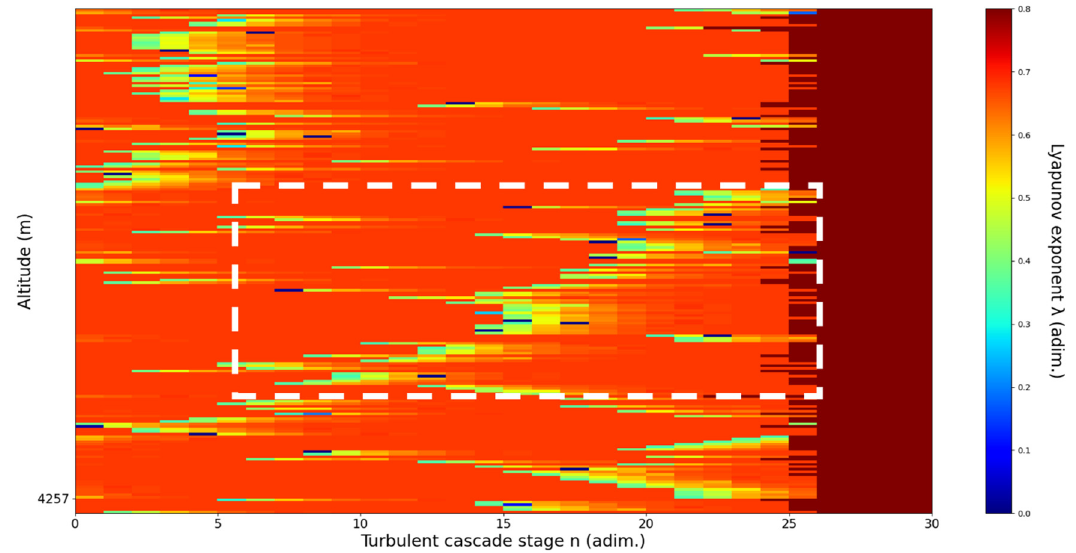
Figure 19. Lyapunov exponent per turbulent cascade stage colormap altitude plot, Bucharest, Romania, 13 June 2019, 07:33:00; point of interest: 4520 m.